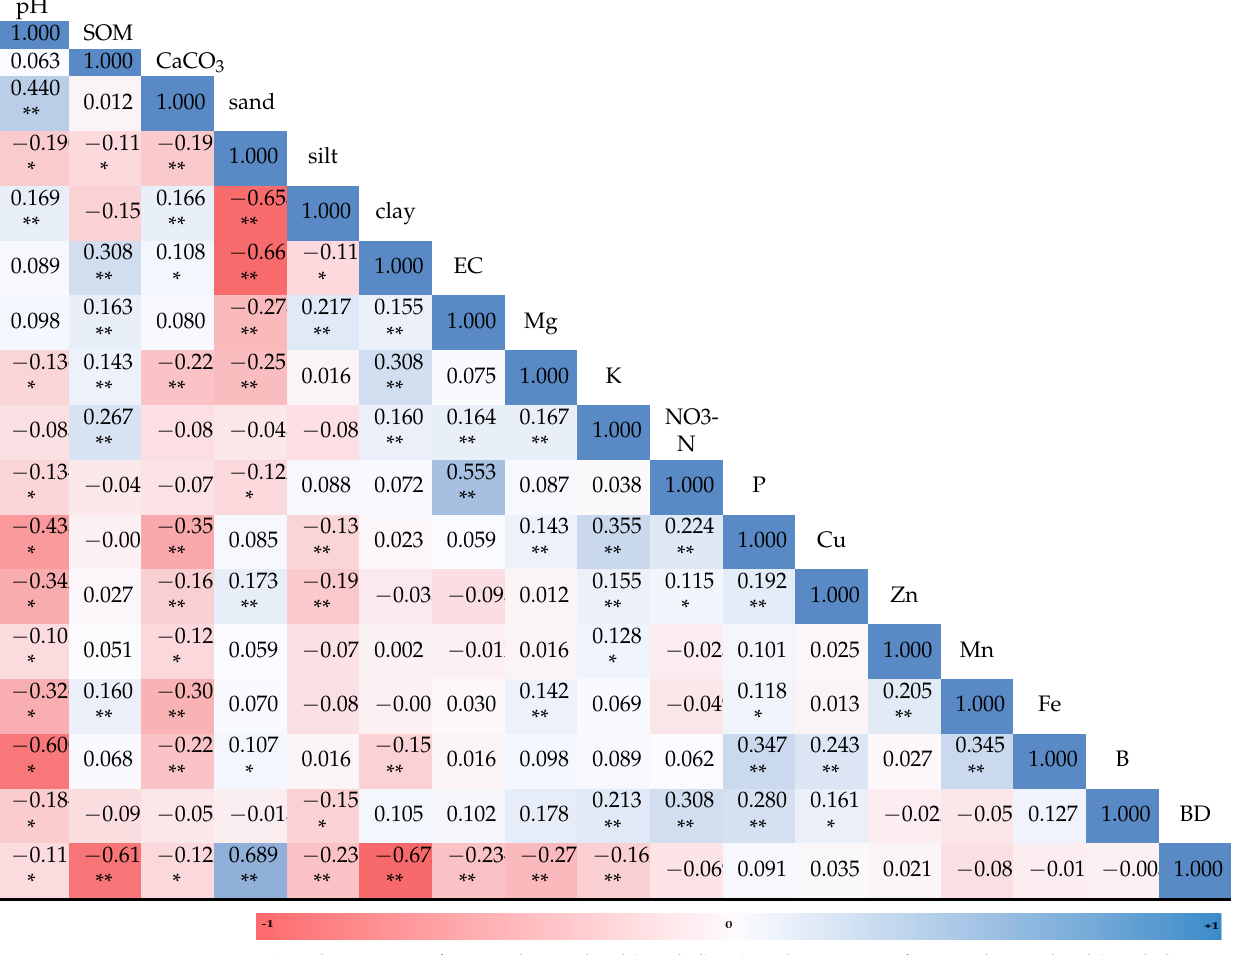
** Correlation is significant at the 0.01 level (2-tailed). * Correlation is significant at the 0.05 level